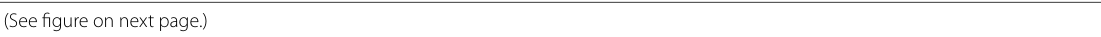
difference(See figure on next Fig. 7 Inhibition of TOP2A affects the development potential and quality of pre-implantation embryos. A Flow chart depicting the protocol used for obtaining embryos. B Immunofluorescence was used to confirm the efficiency of the TOP2A inhibitor PluriSIn2. Total magnification: 400x. Scale bar: 20 μm C TOP2A inhibitor restricted the development of four-cell embryos and blastocysts. Scale bar: 100 μm. D Staining of nucleus/DNA (Hoechst), epiblast (NANOG), primitive endoderm (GATA4), and total ICM (NANOG and GATA4 merged). Scale bar: 20 μm E qRT-PCR was used to analyse the expression of the inducer of ZGA and zygotic genes to assess the effect of PluriSIn2. Total RNA was isolated from four ‐ cell embryos. F The effect of PluriSIn2 on mitochondrial superoxide levels in mouse four-cell embryos. Scale bar: 20 μm. G JC-1 staining of mouse four-cell embryos to determine the effect of PluriSIn2 on mitochondrial potential. Scale bar: 20 μm. * P < 0.05, *** P < 0.001. ns no statistical